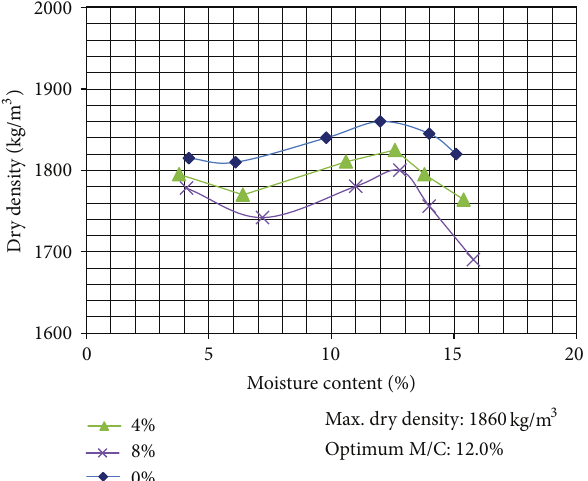
Figure 9: Relationship between optimum moisture content and lime content for stabilized